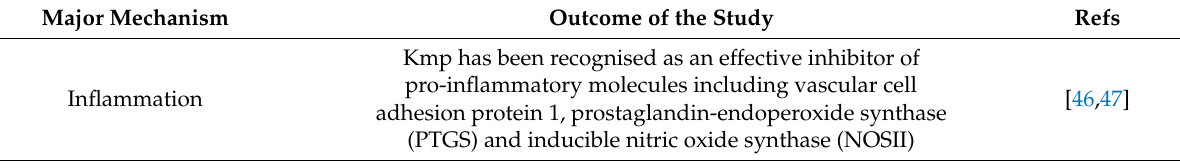
Table 1. Major mechanism of action of Kaempferol (Kmp) in cancer management.